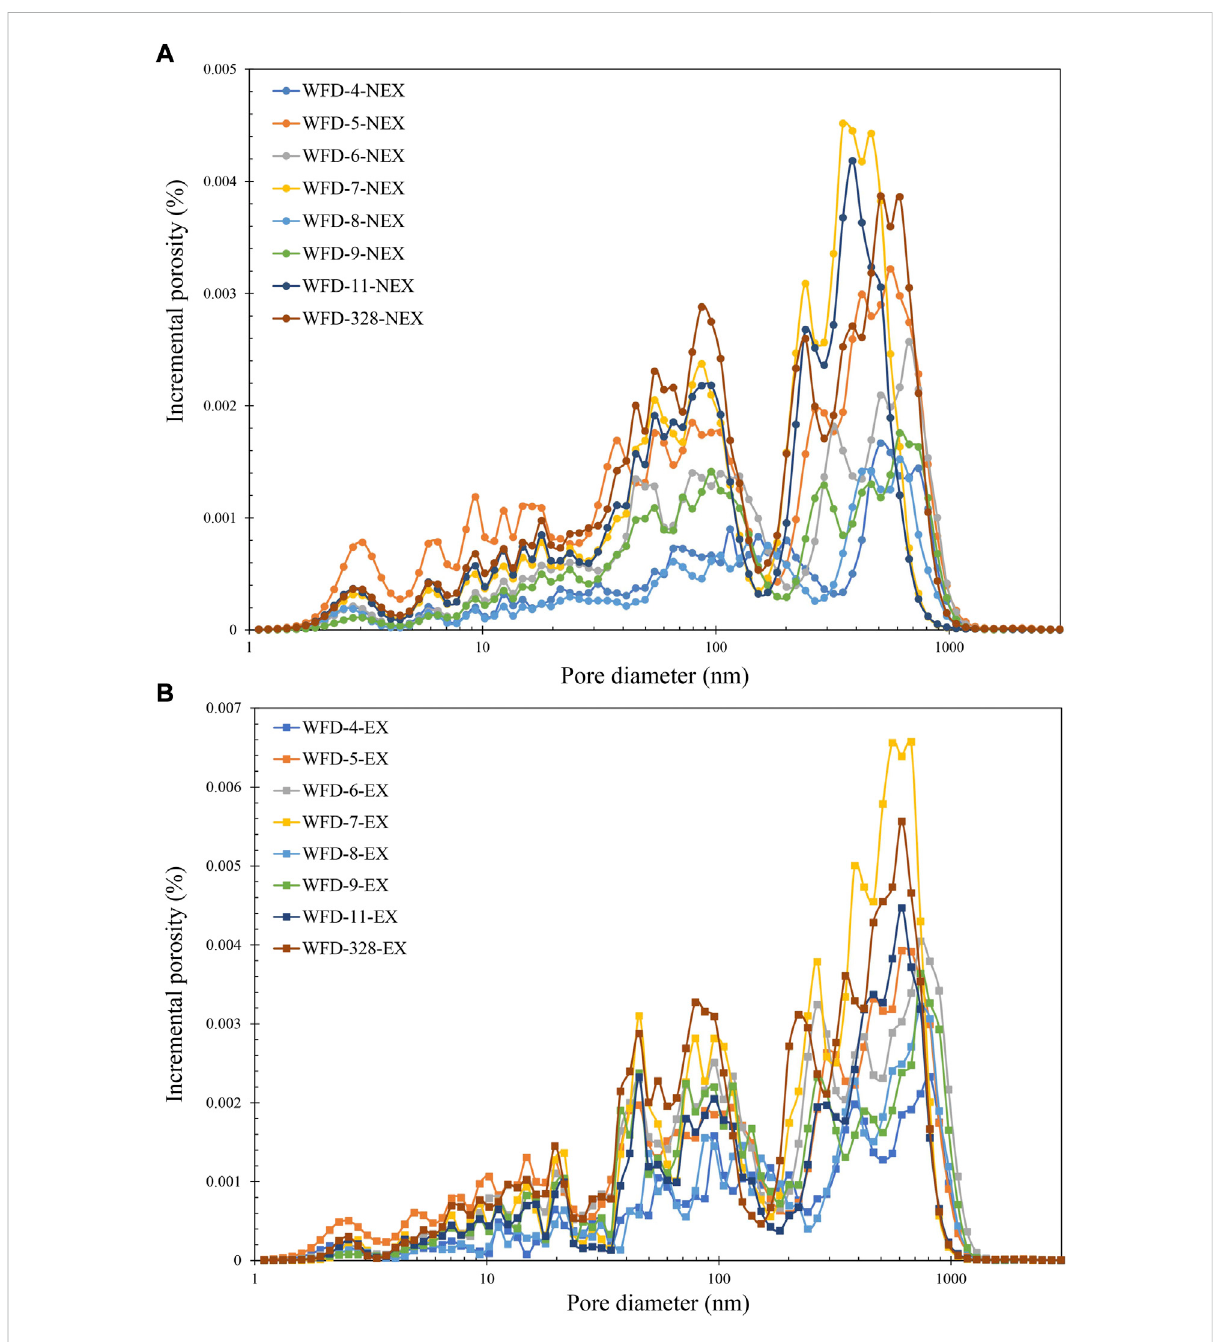
FIGURE 6 Pore diameter distributions of non-extracted (A) and solvent-extracted (B)